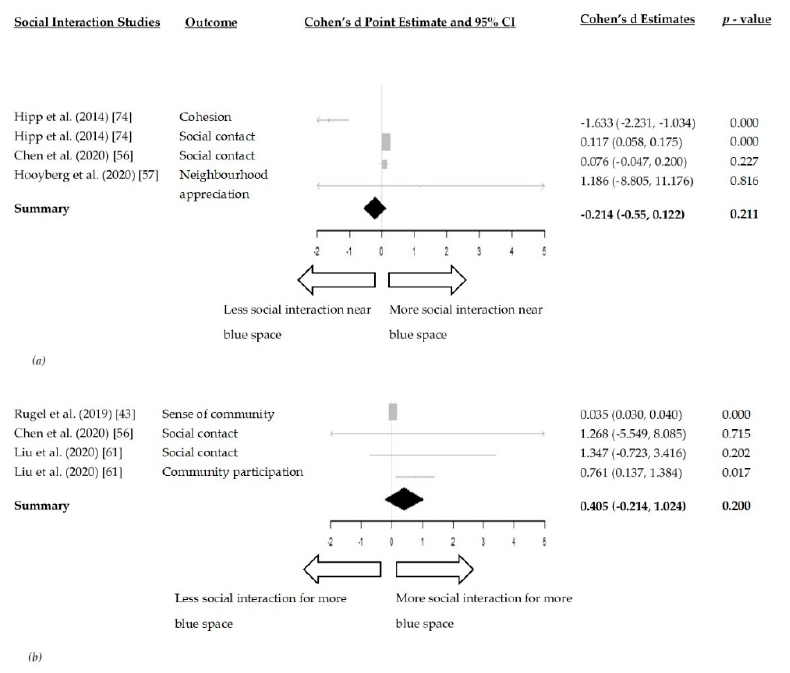
Figure 5. ( a ) Forest plot of the relationship between distance to blue space and social interaction; ( b ) Forest plot of the relationship between amount of blue space within a geographical area and social